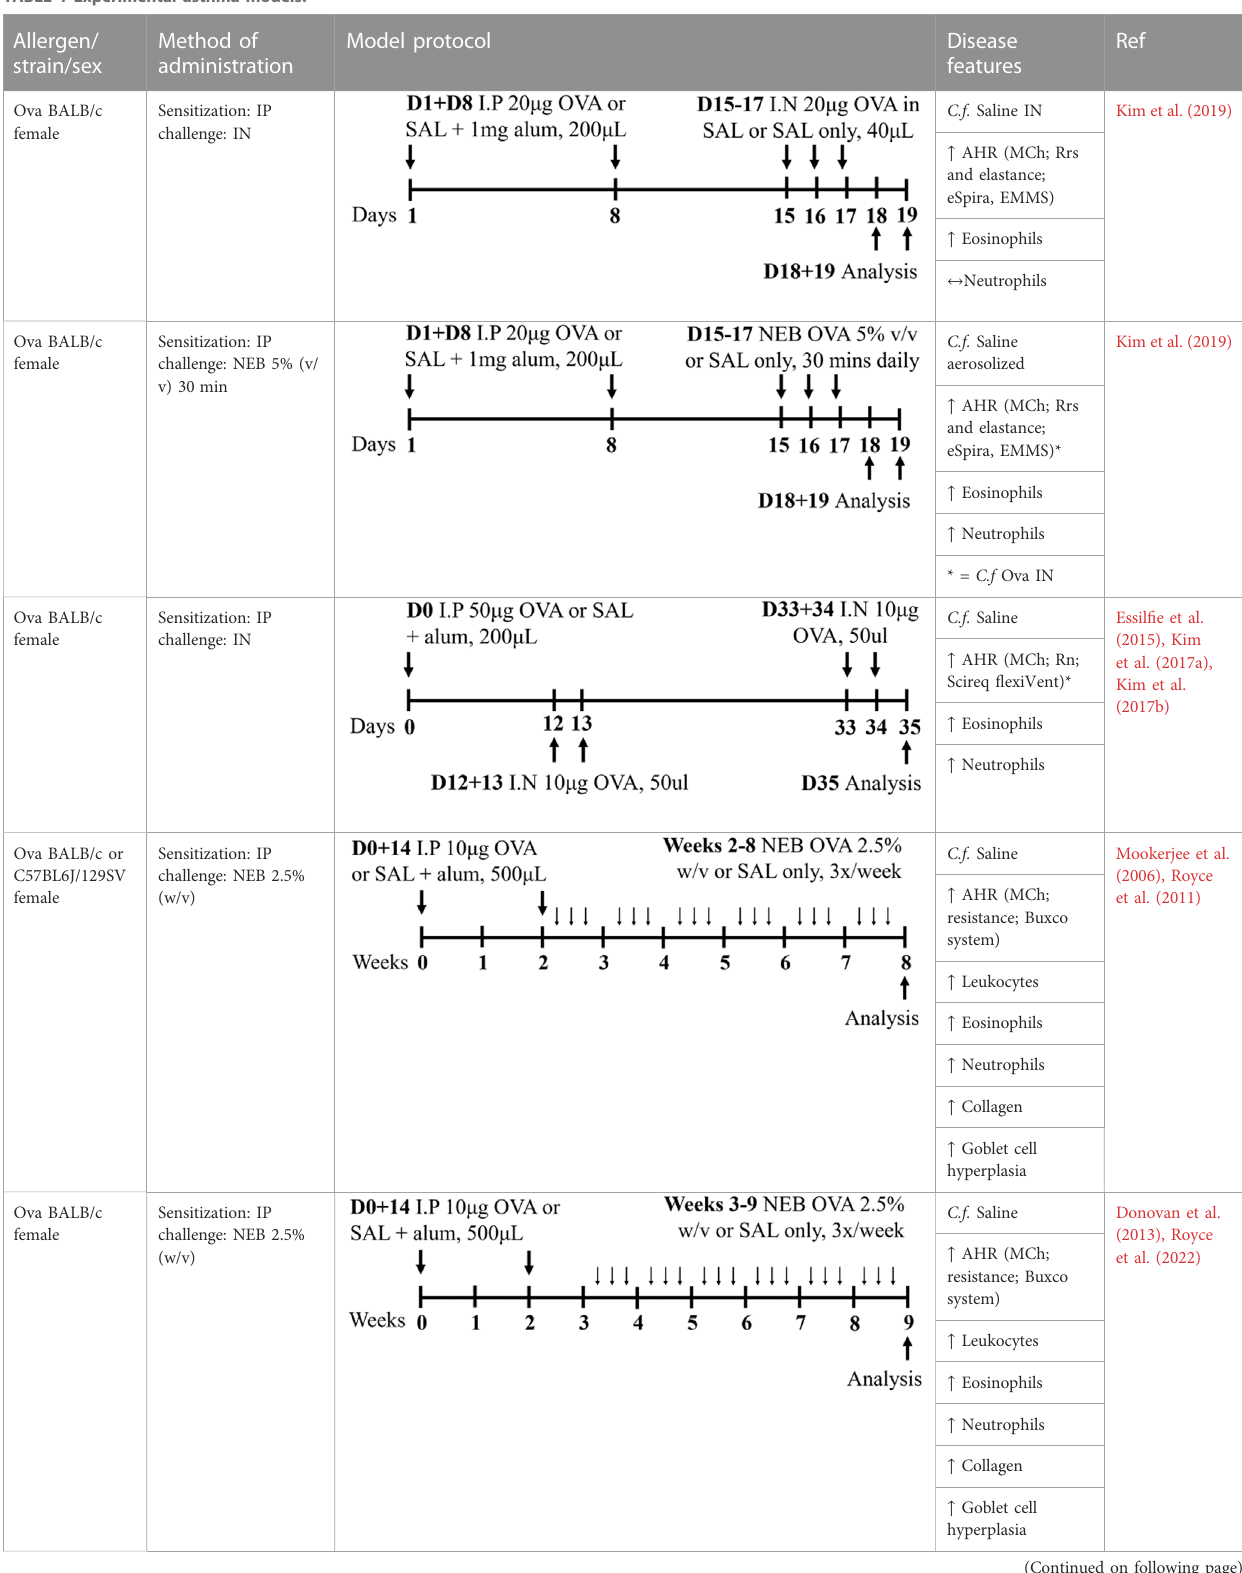
TABLE 1 Experimental asthma